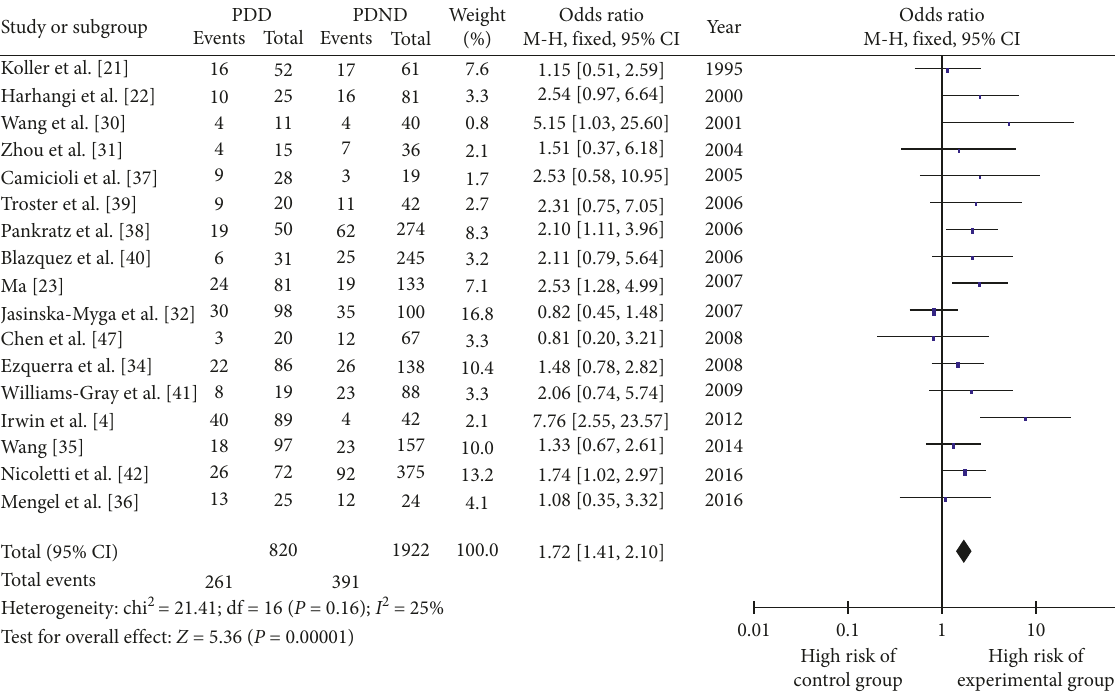
Figure 5: Forest plot for the risk of Parkinson’s disease dementia onset in ε 4+ versus ε 4